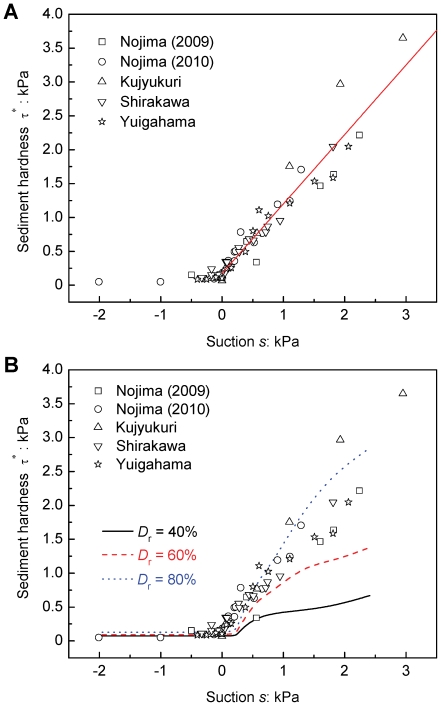
Interrelationships between suction, sediment relative density, and sediment hardness in the laboratory and the field.(A) Measured relationships between sediment hardness τ* and suction s at four intertidal flats and beaches. Both of τ* and s were measured during spring low tides at the Nojima and Shirakawa tidal flats and during spring low tides when the swash retreated in the intertidal zones of Kujyukuri and Yuigahama beaches. All the measured data at the Nojima tidal flat (n = 23, r2 = 0.912, p<0.0001), the Shirakawa tidal flat (n = 20, r2 = 0.967, p<0.0001), Kujyukuri beach (n = 12, r2 = 0.976, p<0.0001), and Yuigahama beach (n = 14, r2 = 0.932, p<0.0001), fell on a unique relationship τ* = 1.02462s+0.17557 (n = 69, r2 = 0.914, p<0.0001). (B) Comparison between the field and laboratory data. The symbols represent the field data shown in (A). The three different lines represent the laboratory data for the three different sediment relative densities D
r = 40%, 60%, 80%, and cover higher suction ranges than those shown in Figure 1D.